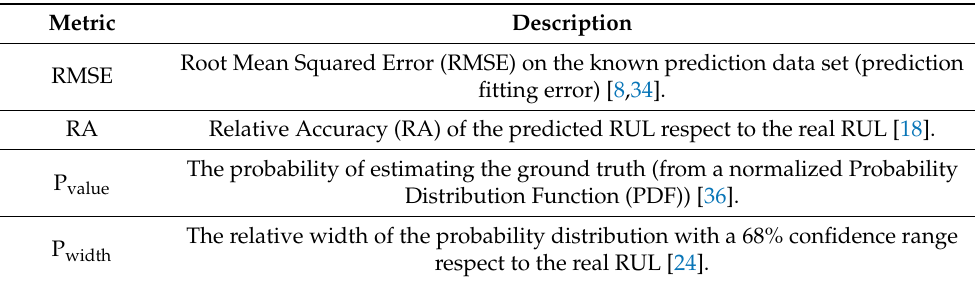
Table 1. Set of metrics that quantifies the correctness.